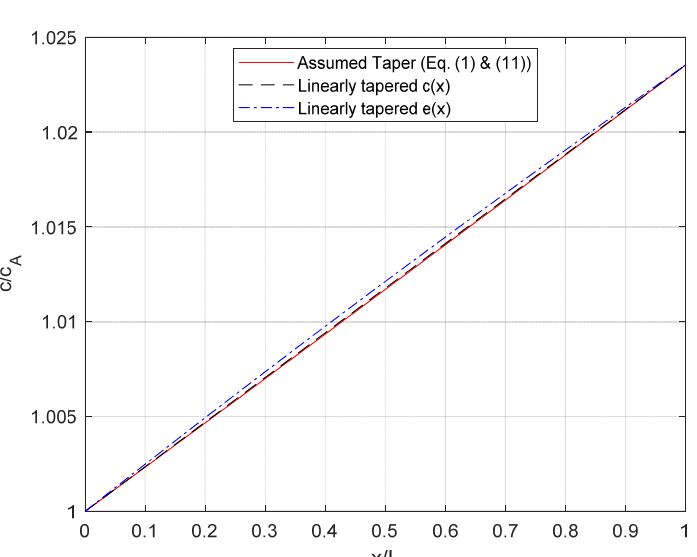
Figure 2. The wave speed profile assumed in Equation (11) results in a wave speed that approximates both the case where the wave speed varies linearly and the case where the tube’s wall thickness varies linearly, as long as the variation in wave speed is small relative to its absolute value. (This example was calculated for E = 200 GPa and K = 1 GPa).